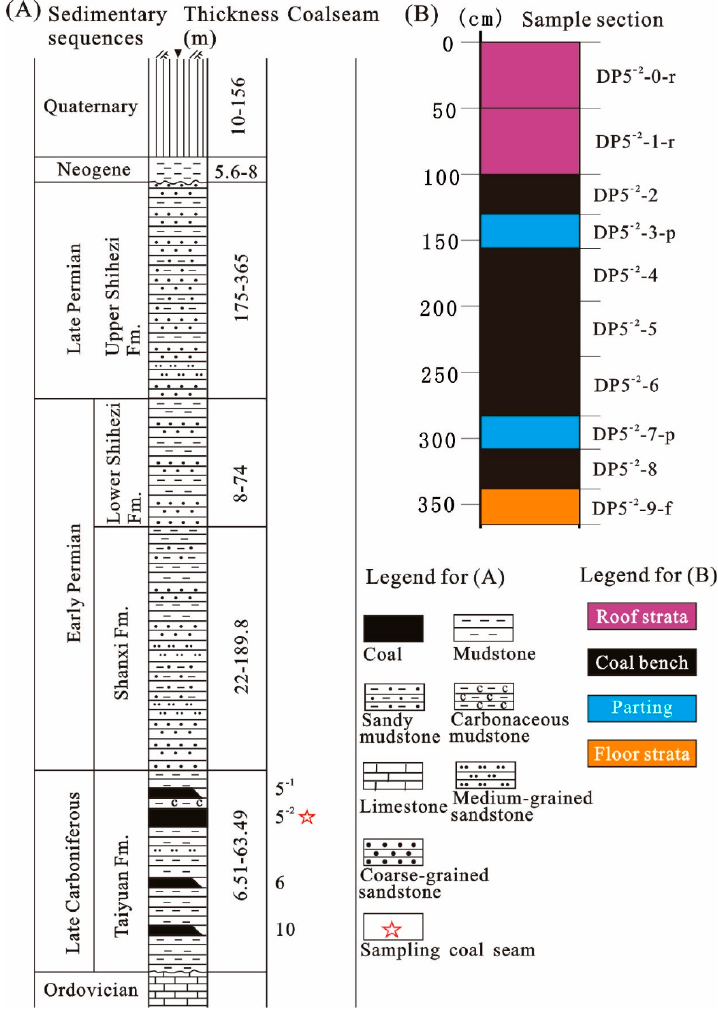
Figure 2. ( A ) Sedimentary sequences and ( B ) the vertical sampled section of the No. 5 -2 coal from Dongpo Mine.